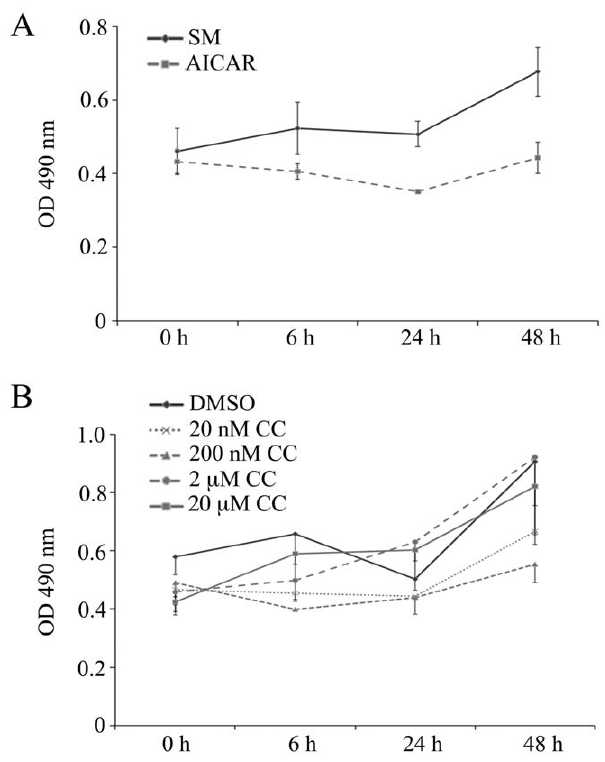
Figure 7. Cell proliferation of NCI-H295R cells. Cells were treated with 1 mM AICAR (A) or 0–20 m M compound C (B) in serum-free medium for 0–48 hours. A commercially available cell proliferation assay was performed (Promega). Results are expressed as OD490 nm which corresponds directly to cell viability in this assay. Data are the mean of two independent experiments 6 S.E.M.